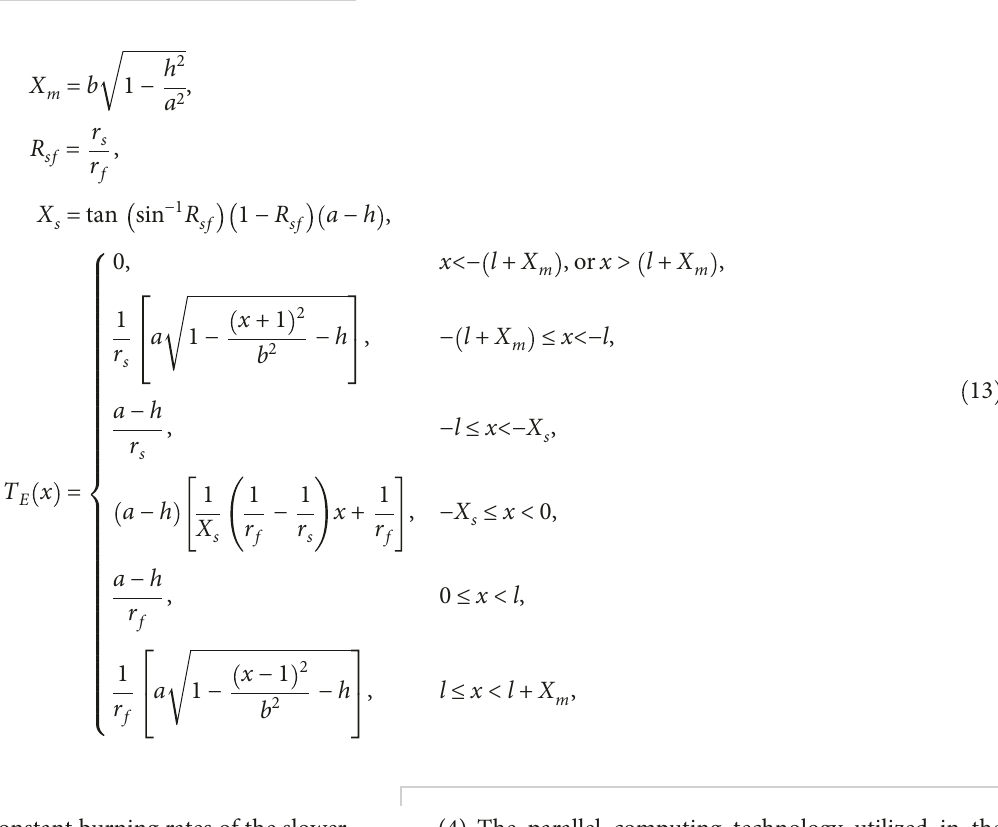
Procedure 1. Discretizing the CAD model shown by Figure 4 using di ff erent controlling parameters, three trian- gular models containing 1336, 3497, and 4635 triangles, respectively, are generated. Then, we generate the sampling points via the AABB tree approach [18] and Procedure 1, respectively. Repeating the computation and averaging the execution time, we get the pro fi ling result shown by Figure 14, where n r = 180 , n s = 128, 256, 512, 1024 , and the “ FAST ” labels mark the data measured from Procedure